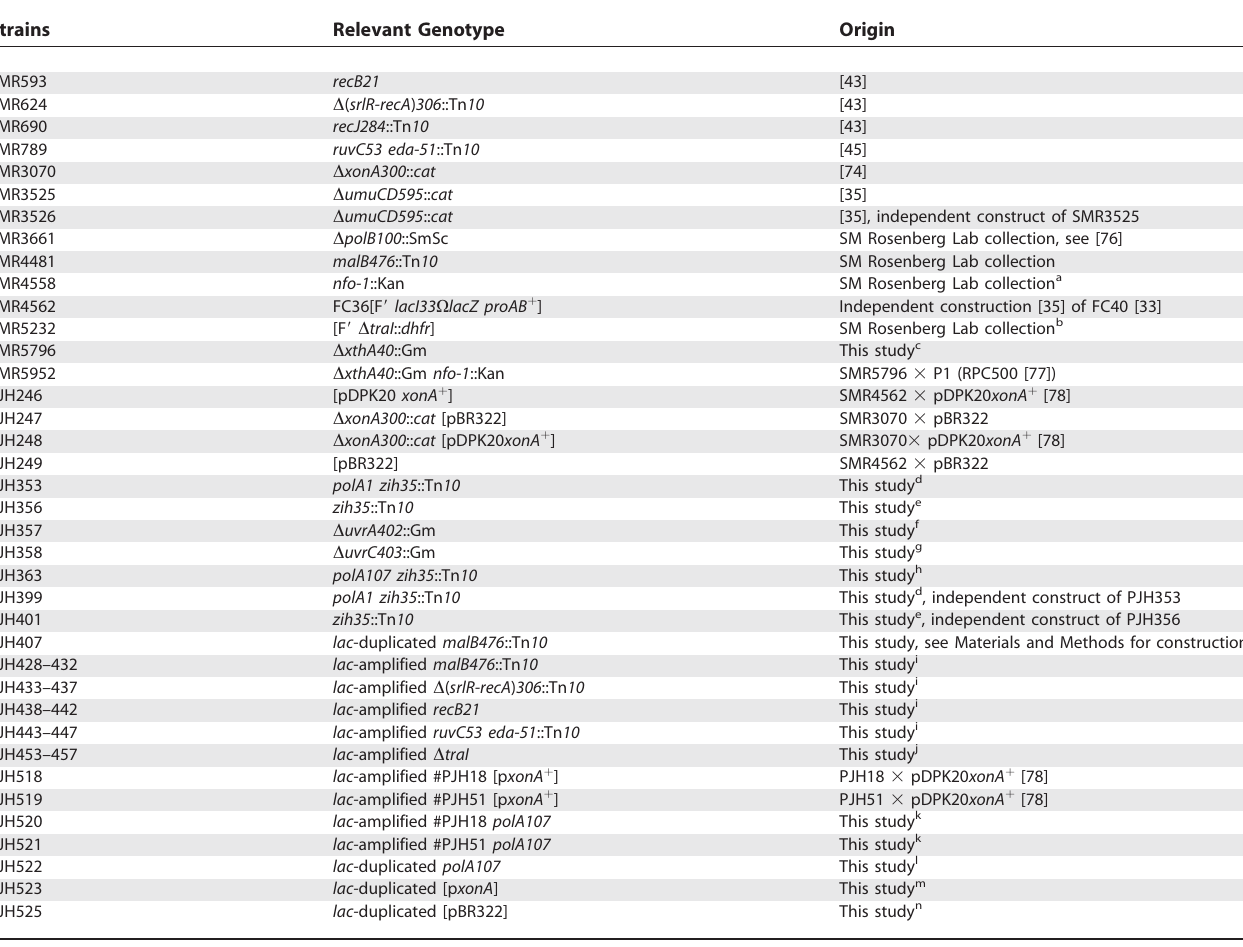
Table 2. Origins of E. coli Strains Used Strains Relevant